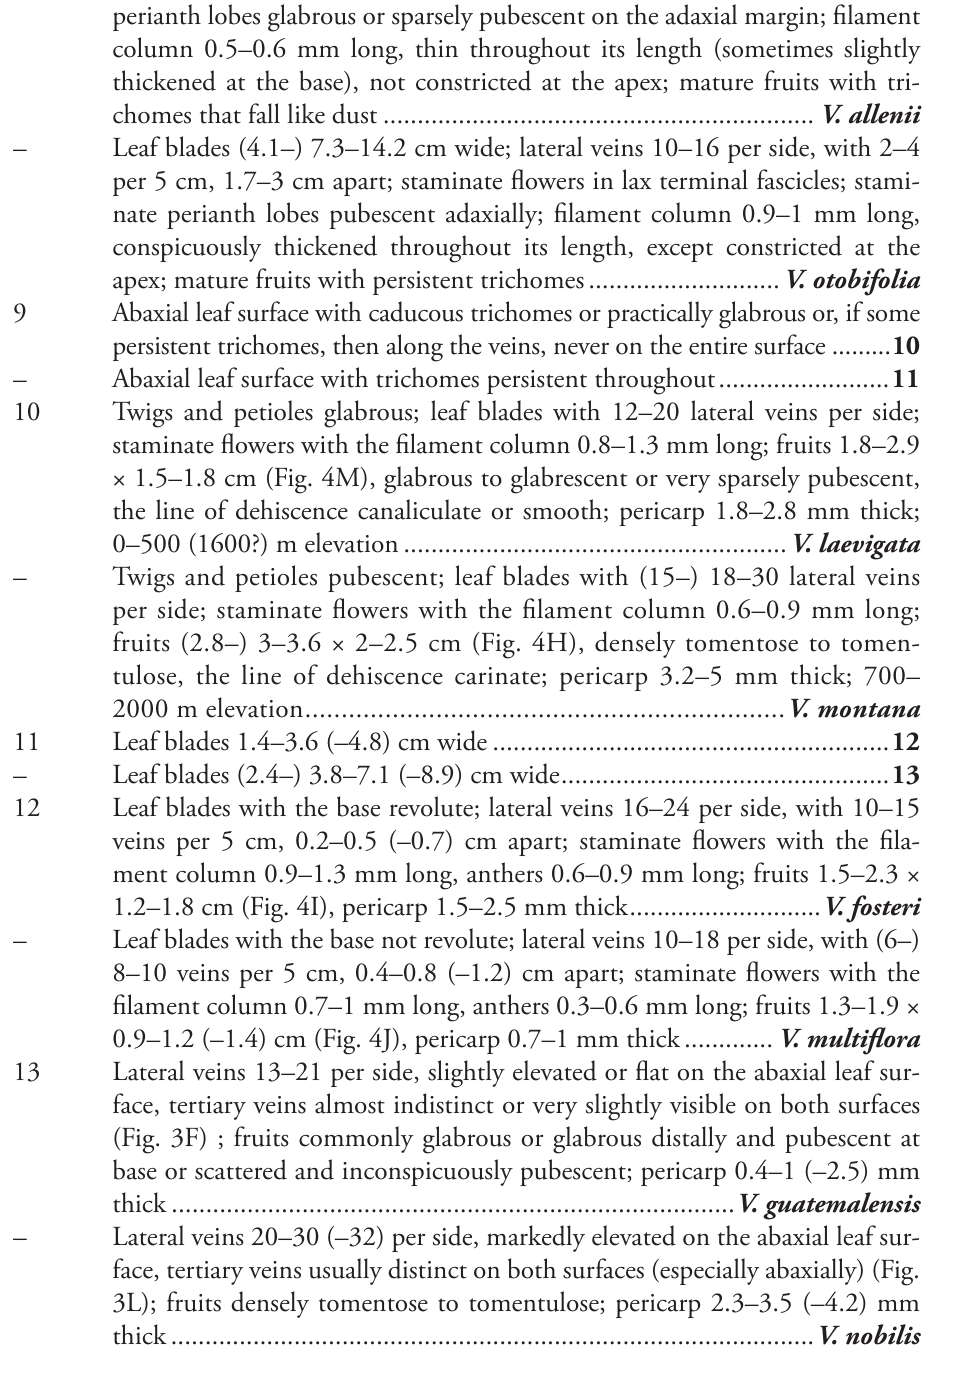
perianth lobes glabrous or sparsely pubescent on the adaxial margin; filament column 0.5–0.6 mm long, thin throughout its length (sometimes slightly thickened at the base), not constricted at the apex; mature fruits with tri- chomes that fall like dust ............................................................... V. allenii Leaf blades (4.1–) 7.3–14.2 cm wide; lateral veins 10–16 per side, with 2–4 per 5 cm, 1.7–3 cm apart; staminate flowers in lax terminal fascicles; stami- nate perianth lobes pubescent adaxially; filament column 0.9–1 mm long, conspicuously thickened throughout its length, except constricted at the apex; mature fruits with persistent trichomes ............................ V. otobifolia 9 Abaxial leaf surface with caducous trichomes or practically glabrous or, if some persistent trichomes, then along the veins, never on the entire surface ......... 10 Abaxial leaf surface with trichomes persistent throughout ......................... 11 Twigs and petioles glabrous; leaf blades with 12–20 lateral veins per side; staminate flowers with the filament column 0.8–1.3 mm long; fruits 1.8–2.9 × 1.5–1.8 cm (Fig. 4M), glabrous to glabrescent or very sparsely pubescent, the line of dehiscence canaliculate or smooth; pericarp 1.8–2.8 mm thick; 0–500 (1600?) m elevation ........................................................ V. laevigata Twigs and petioles pubescent; leaf blades with (15–) 18–30 lateral veins per side; staminate flowers with the filament column 0.6–0.9 mm long; tulose, the line of dehiscence carinate; pericarp 3.2–5 mm thick; 700– 2000 m elevation .................................................................. V. montana Leaf blades 1.4–3.6 (–4.8) cm wide .......................................................... 12 Leaf blades with the base revolute; lateral veins 16–24 per side, with 10–15 veins per 5 cm, 0.2–0.5 (–0.7) cm apart; staminate flowers with the fila- ment column 0.9–1.3 mm long, anthers 0.6–0.9 mm long; fruits 1.5–2.3 × 1.2–1.8 cm (Fig. 4I), pericarp 1.5–2.5 mm thick ............................ V. fosteri